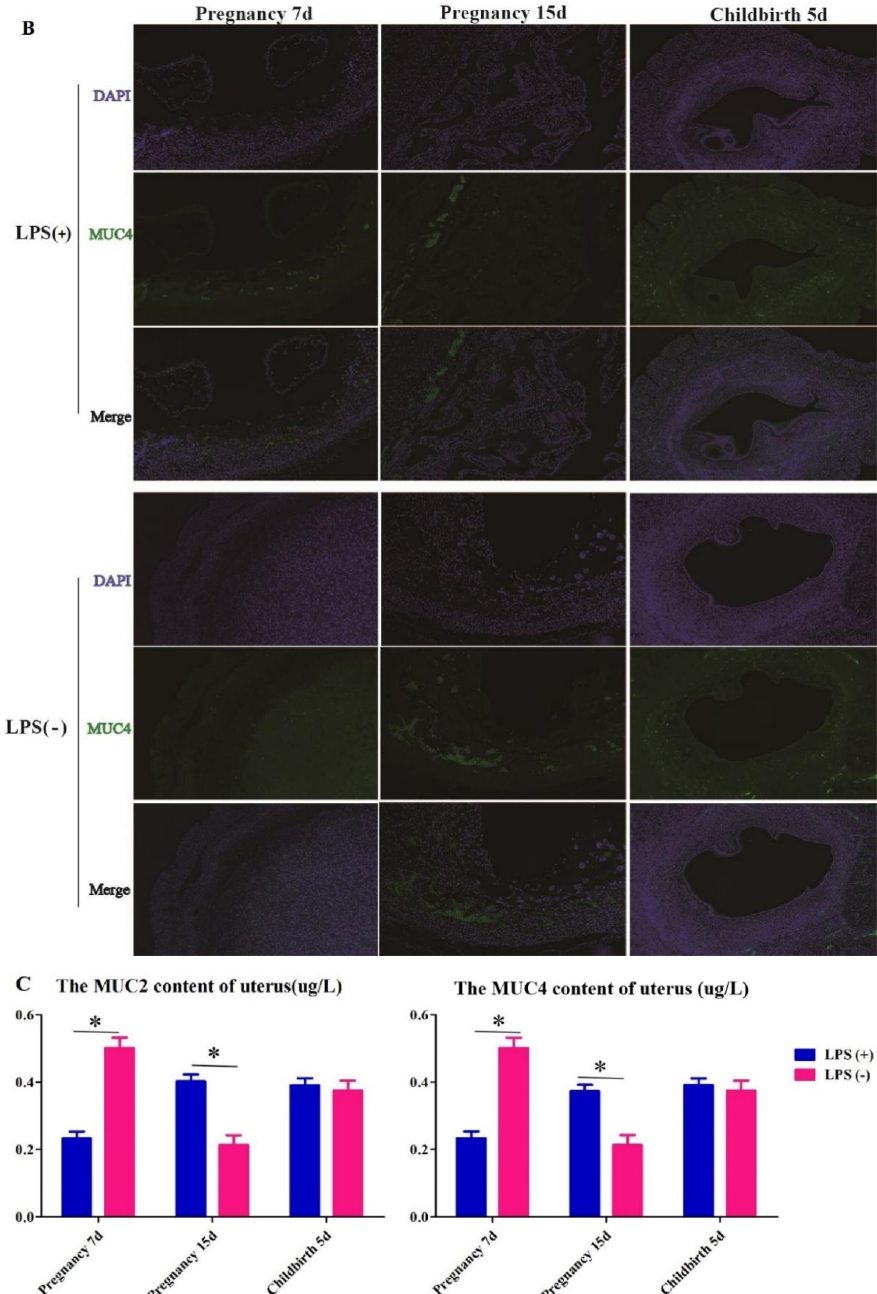
Figure 2. Effect of LPS on MUC2 and MUC4 expressions and distribution in uteri in LPS (+) and LPS (-) groups during pregnancy and after childbirth. Immunofluorescent staining results showed MUC2 (red) expression and nucleus (blue) in the uteri in LPS (+) and LPS (-) groups at day 7 and day 15 of pregnancy and 5 days after childbirth (×100) ( A ). Immunofluorescent staining results showed MUC4 (green) expression and nucleus (blue) in the uteri in LPS (+) and LPS (-) groups at day 7 and day 15 of pregnancy and 5 days after childbirth (×100) ( B ). ELISA results showed MUC2 and MUC4 protein content in endometria in LPS (+) and LPS (-) group at day 7 and day 15 of pregnancy and days after childbirth ( C ). * Statistical difference between LPS (+) and LPS (-) groups in the same period ( p < 0.05). At day 7 of pregnancy, MUC4 expression was obviously increased in the LPS (-) group. At day 15 of pregnancy, MUC4 expression in the endometrium of the LPS (+) group was higher than that in the LPS (-) group. Five days after childbirth, MUC4 expression